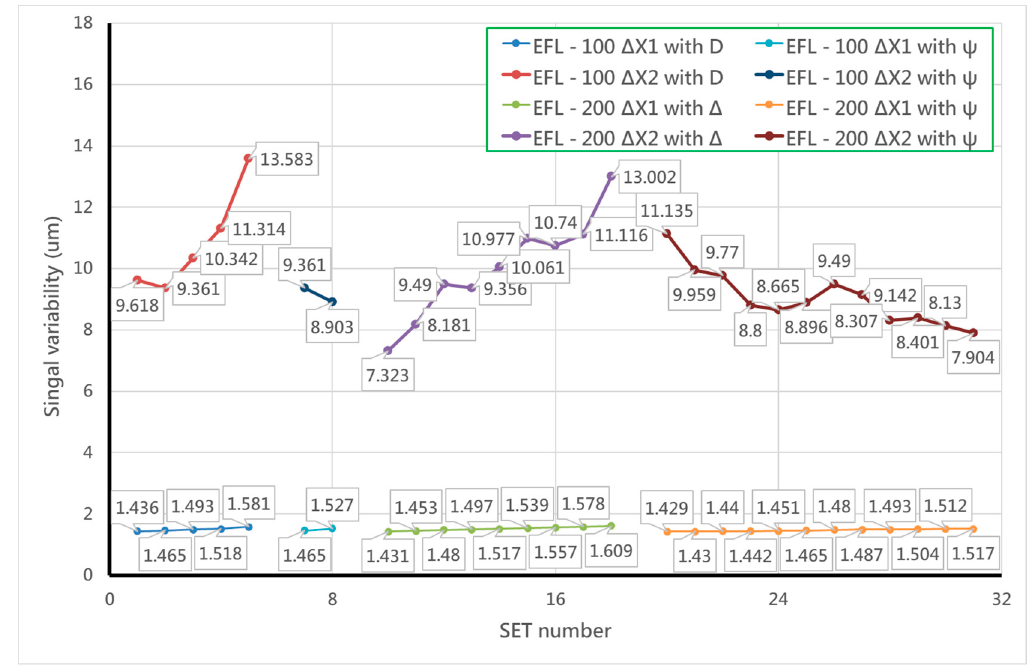
Figure 10. Our simulation of the optimal parameters of the rear focal point.